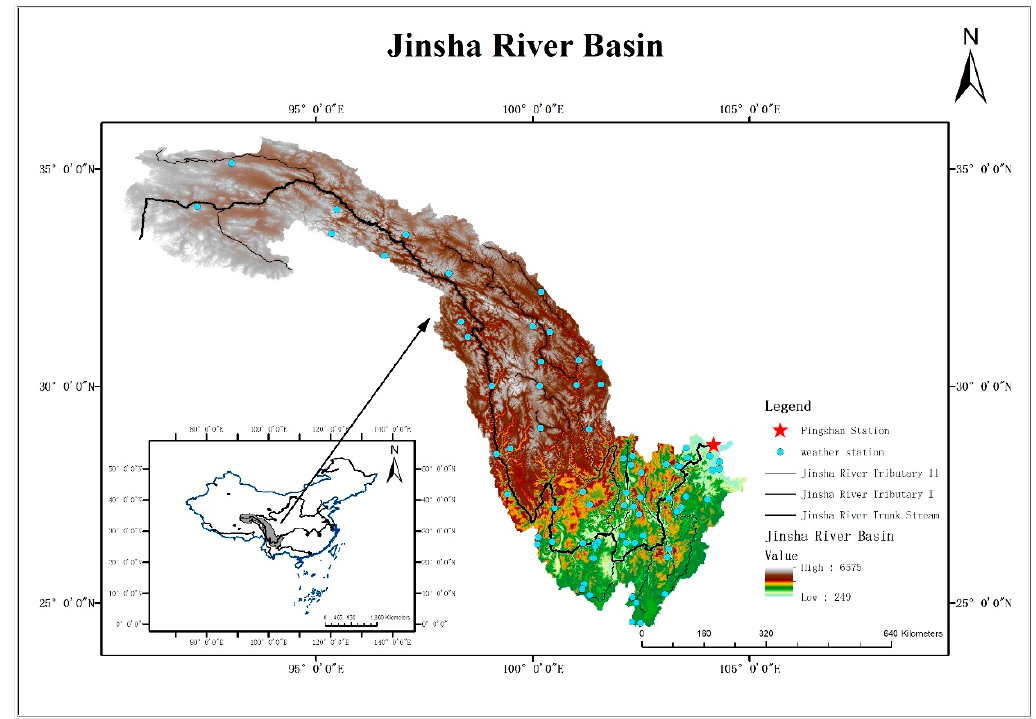
Figure 1. The Jinsha River Basin.